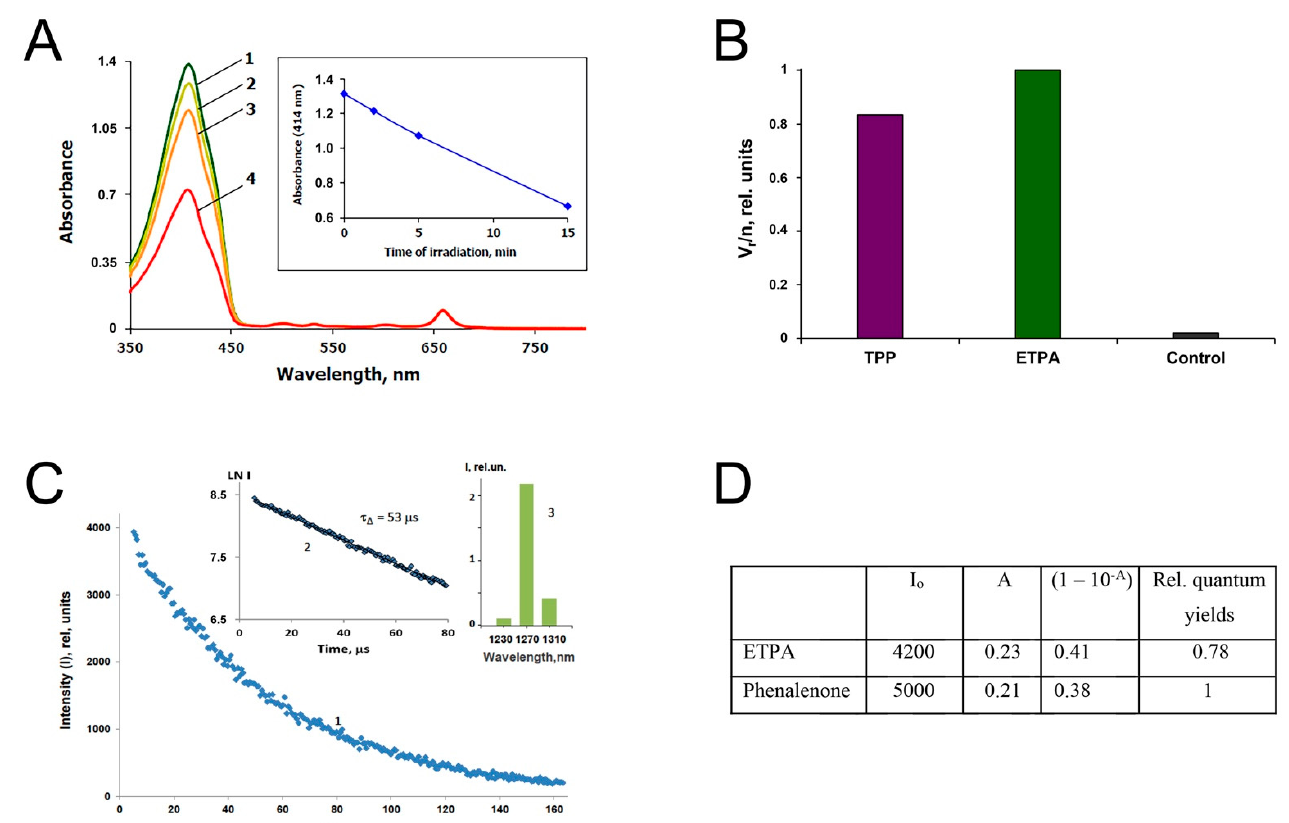
Figure 3. ETPA efficiently generates singlet oxygen: ( A ) changes in the absorption spectrum of DPIBF (curves 1–4) in the mixture of DPIBF with ETPA in acetone during irradiation by monochromatic red light (660 nm) absorbed by ETPA. Here, “2” corresponds to 2 min, “3” refers to 5 min, and “4” to 15 min irradiation. Power of exciting light was 83 µ W. Inset shows the time course of 414 nm absorption fall of DPIBF. ETPA bleaching was not observed; ( B ) the relative quantum yields of DPIBF oxidation (V r /n) upon irradiation of TPP and ETPA. The rate of spontaneous DPIBF bleaching in the dark without sensitizer and irradiation is defined as “Control”. For TPP, irradiation time was 10 min, excitation wavelength was 512 nm, irradiation power was 105 μ W, and absorbance of TPP at 512 nm was 0.024. For ETPA, irradiation time was 2 min, excitation wavelength was 660 nm, excitation power was 83 µ W, and absorbance at 660 nm was 0.095; ( C ) kinetic trace of photosensitized phosphorescence of singlet oxygen upon excitation of ETPA by 5 µ s pulses of violet LED (399 nm) in cartesian (1) and semilogarithmic (2) coordinates. Pulse repetition rate was 5 kHz, average LED power was 30 mW, and irradiation (averaging) time was 10 min. The PMT signal was accumulated using a time-resolved computer photon counting. The duration of one channel was 640 ns, and the number of channels was 256. Absorbance of the solution at 396 nm was 0.246 in a 1 cm quartz cell. Here, “3” indicates phosphorescence emission spectrum estimated using three interchangeable interference filters. I corresponds to the phosphorescence intensity just after the end (5 μ s) of the LED pulse. The decay time ( τ Δ ) of the phosphorescence exactly coincided with the known value of singlet oxygen lifetime in acetone; ( D ) calculation of the quantum yield of singlet oxygen by ETPA in comparison with phenalenone.